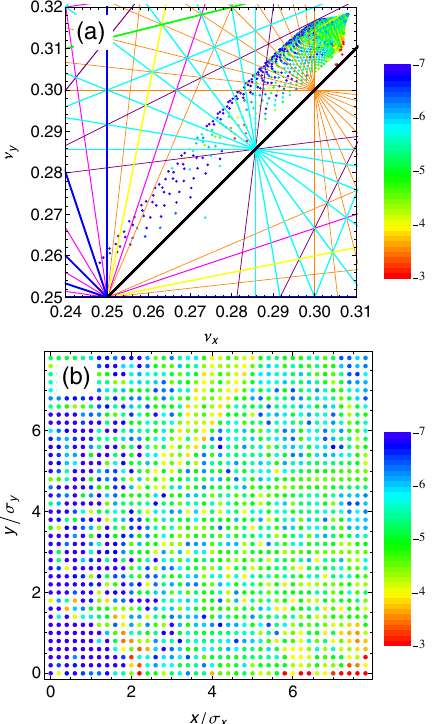
FIG. 6. Diffusion index for collision with a transverse offset of 20% σ